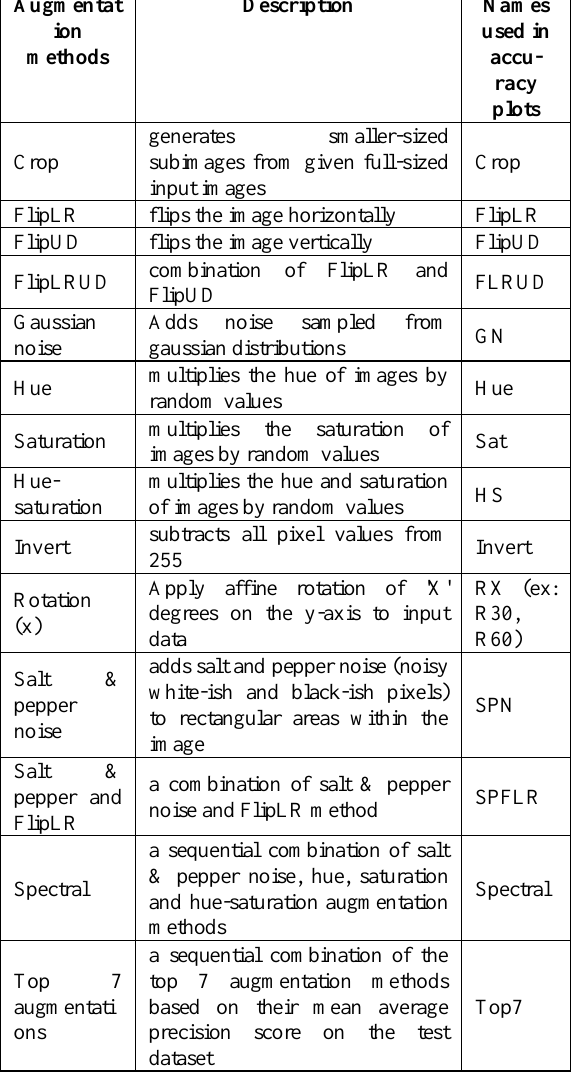
Table 1. Augmentation methods used in this